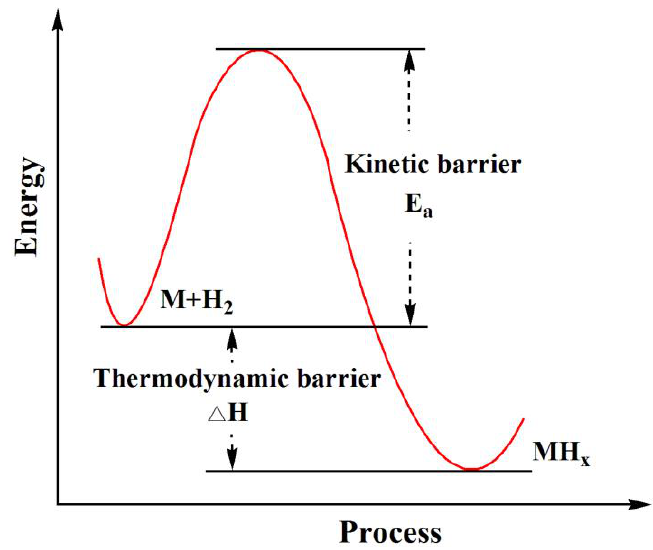
Figure 1. Schematic illustration of thermodynamic and kinetic barrier for de-/hydriding reactions of metal hydrides. Adapted with permission from [17], Copyright Elsevier, 2016.